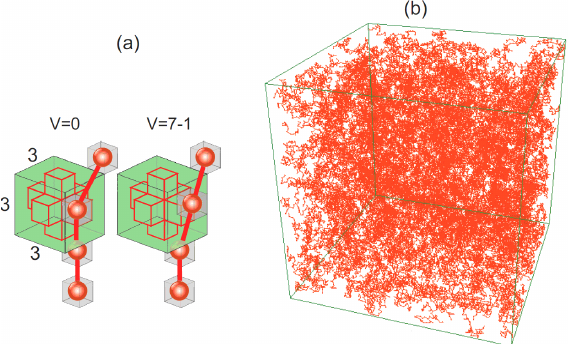
Figure 2. ( a ) Parameter V —a scheme of calculations. ( b ) Snapshot of the simulation: configuration of polymer system. 10% of all polymer chains are